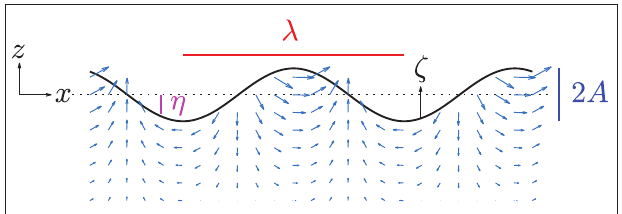
FIGURE 2 | Example of the wave geometry and the wave induced velocity field shown as scaled vectors. The wave is traveling in the postive x direction, with wavelength λ and wave amplitude A . The free surface is denoted by η , and ζ is the coordinate representing distance from the instantaneous free surface.